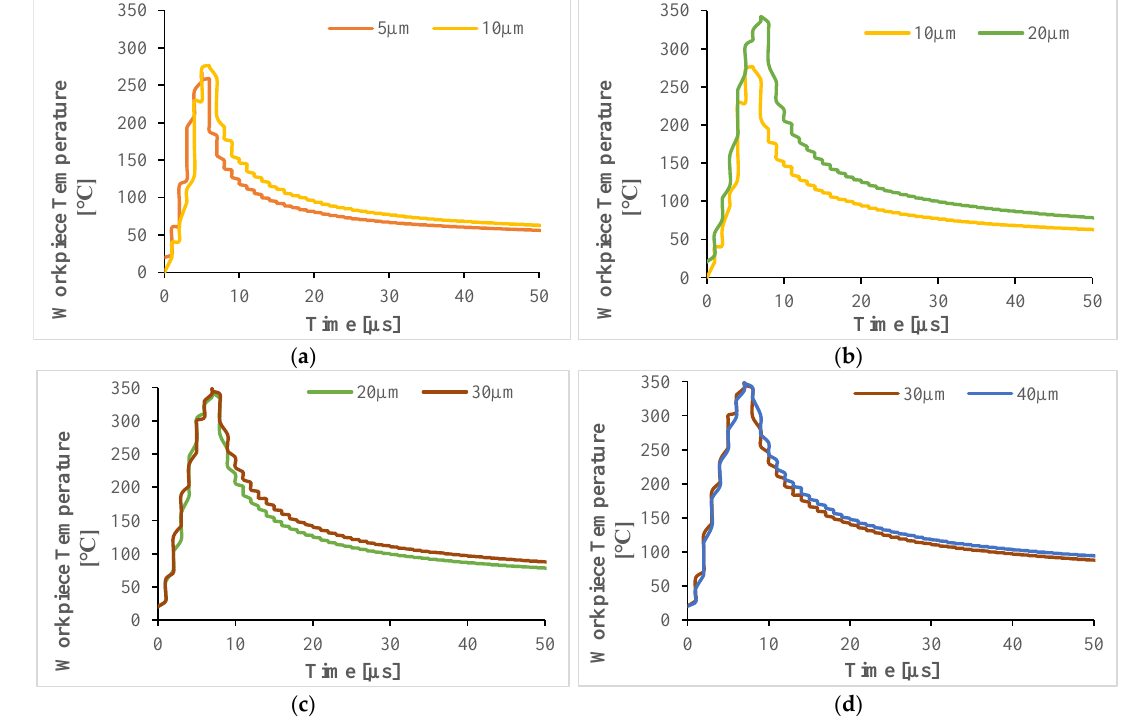
Figure 7. Workpiece surface temperature respect to the edge radius (α = 7° and γ = 17.5°): ( a ) 5–10 µm, ( b ) 10–20 µm, ( c ) 20–30 µm, and ( d ) 30–40 µm.